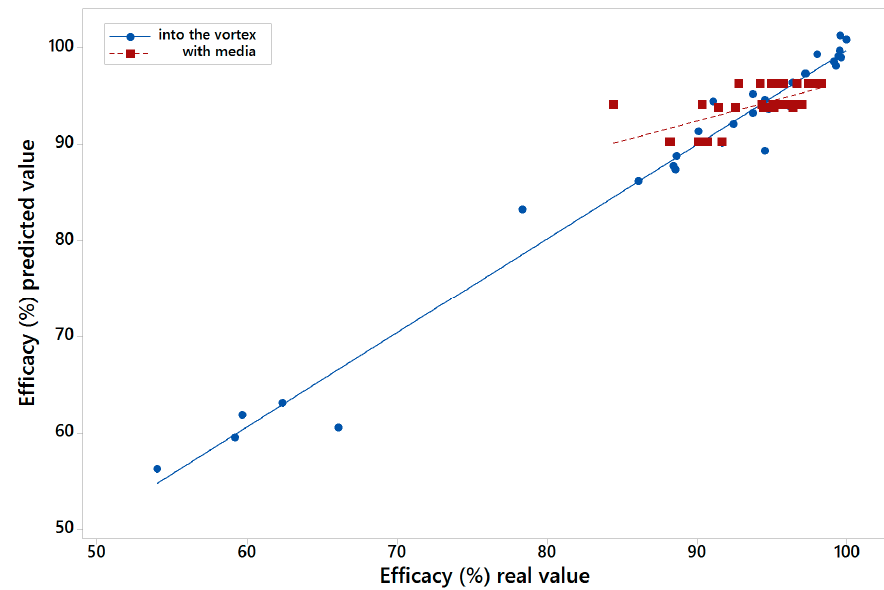
Figure 6. Real value of efficacy versus the calculated by MARS model one for into the vortex and with media feed tests. Materials 2017 , 10 , 729